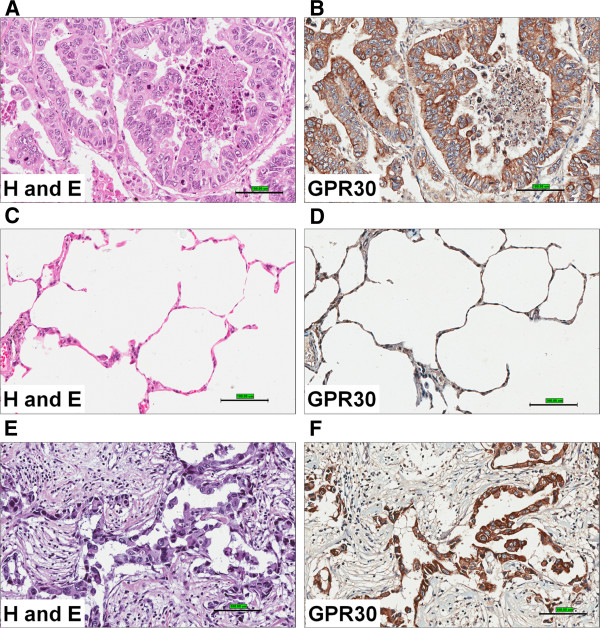
GPER/GPR30 expression in human lung and breast tumors. The TMA slides, ‘Multiple lung cancer test array with unmatched normal adjacent tissue’ (US BioMax Inc, #LC242) and ‘human breast cancer test tissue array with self-matching or unmatched normal adjacent tissues’ (US Biomax Inc #BR241) were stained with H&E and anti-GPR30 (10 μg/ml). (A-B). The representative tissue spot/core images of Hand E (A) and GPR30 (B) staining for lung cancer (adenocarcinoma) are shown. (C-D). The representative normal lung tissue for H and E (C) and GPR30 staining (D) are shown. (E-F) The breast cancer TMA slides were stained with H&E and anti-GPR30 as a positive control for GPR30 expression. The images were collected at 200X magnification using Aperio image scope. The scale bars indicate 100 μm.